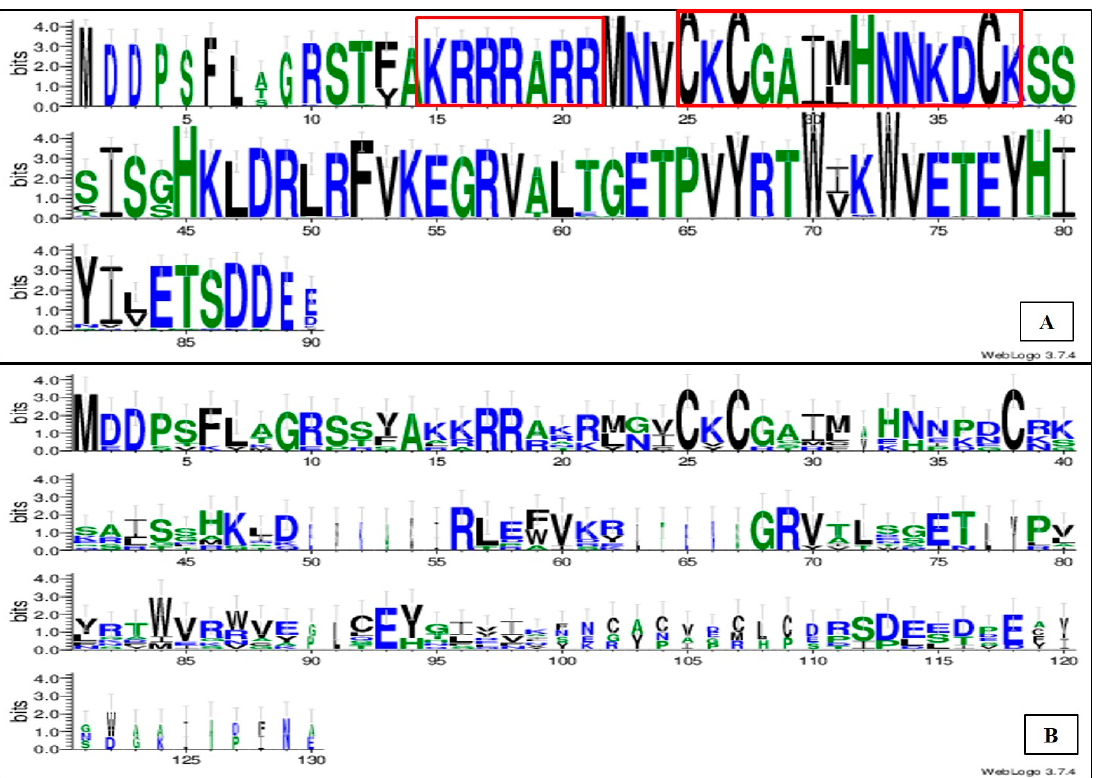
Figure 2. Weblogo depicting the multiple sequence alignment of the partial p10 protein sequences of the new GVA isolates collected in Iran ( A ). ( B ) shows the same analysis conducted including the RNA binding protein sequences of GVA, GVD (CAA69071), GVK (YP_009389467), GVJ (YP_009551971), GVH (YP_009551909), AVA (AET36889), and AVB (YP_004935362). The y-axis represents the bit score, where 4 means 100% conservation. The x-axis displays the amino acid position in the mul- tiple sequence alignment. The arginine-rich motif (ARM) and the zinc-finger motif are shown in red